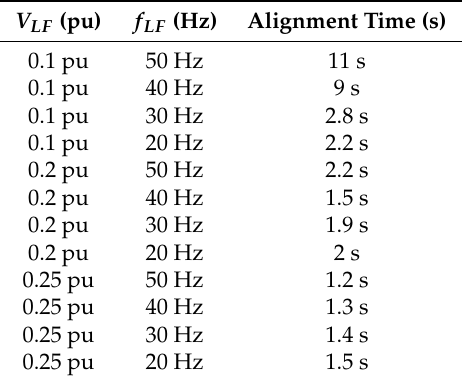
Table 3. The sensitivity analysis results based on the input applied voltage amplitude V LF , the injected signal frequency f LF versus the time duration of the alignment. V LF (pu) f LF